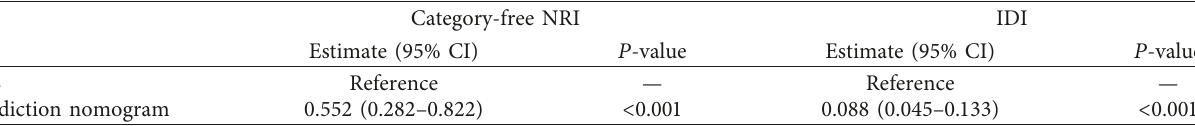
Figure 4: Calibration curves of the nomogram in training set (a) and in validation set (b). Notes: The x -axis represents the predicted OSA probability. The y -axis represents the actual identified patients with OSA. The diagonal dotted line represents a perfect prediction by an ideal model. The solid line represents the performance of the nomogram, of which a closer fit to the diagonal dotted line represents a better prediction. OSA, obstructive sleep apnea. Table 4: Reclassification analyses for ESS and prediction nomogram to improve the risk prediction of OSA.